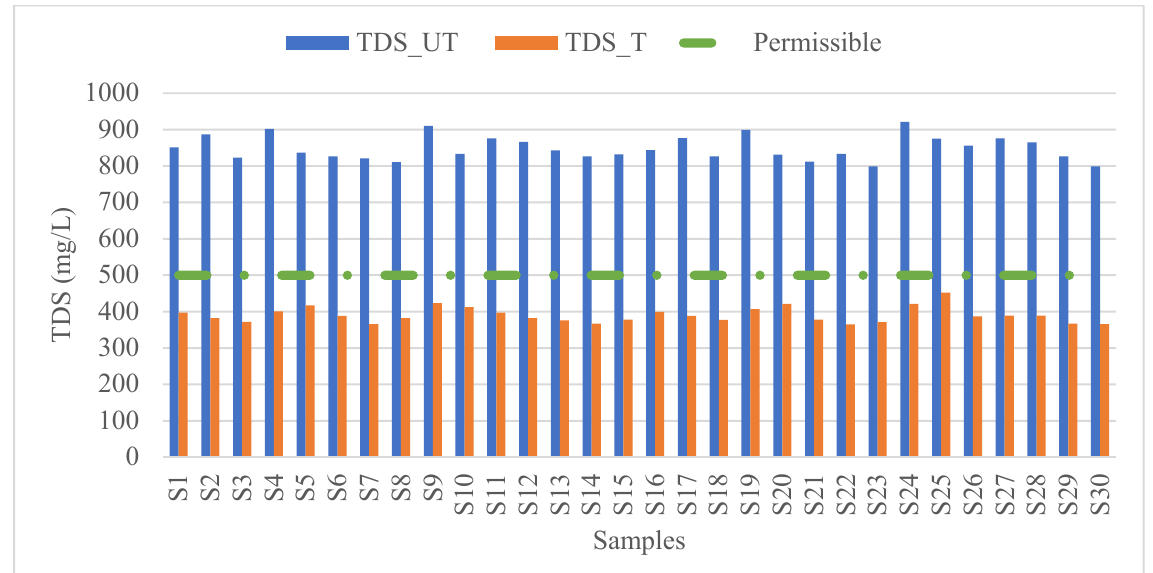
Figure 5. TDS of untreated (UT) and treated (T) water samples and permissible limits.